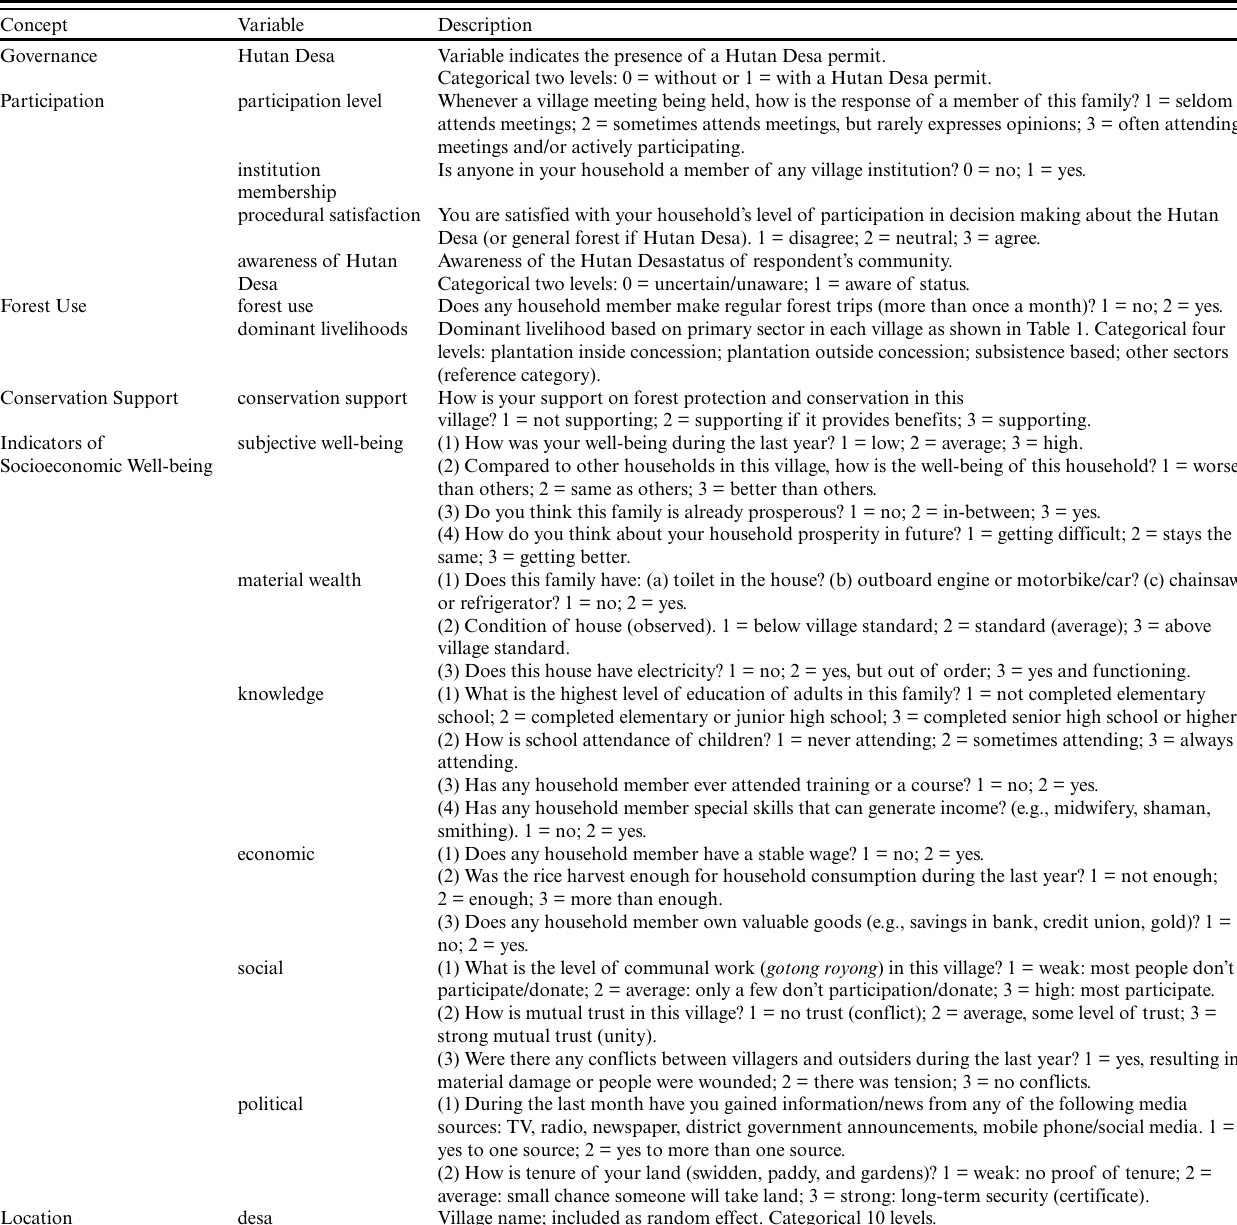
Table 2 . Definitions of variables used in the study. Demographic variables including ethnic group and migrant status were also collected, but were not included as covariates because of the homogeneity within